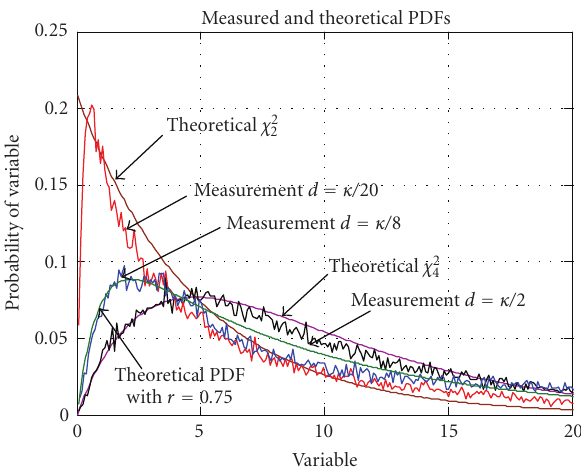
Figure 11: PDFs of the synthetic array under H 1 state for di ff erent antenna spacings.